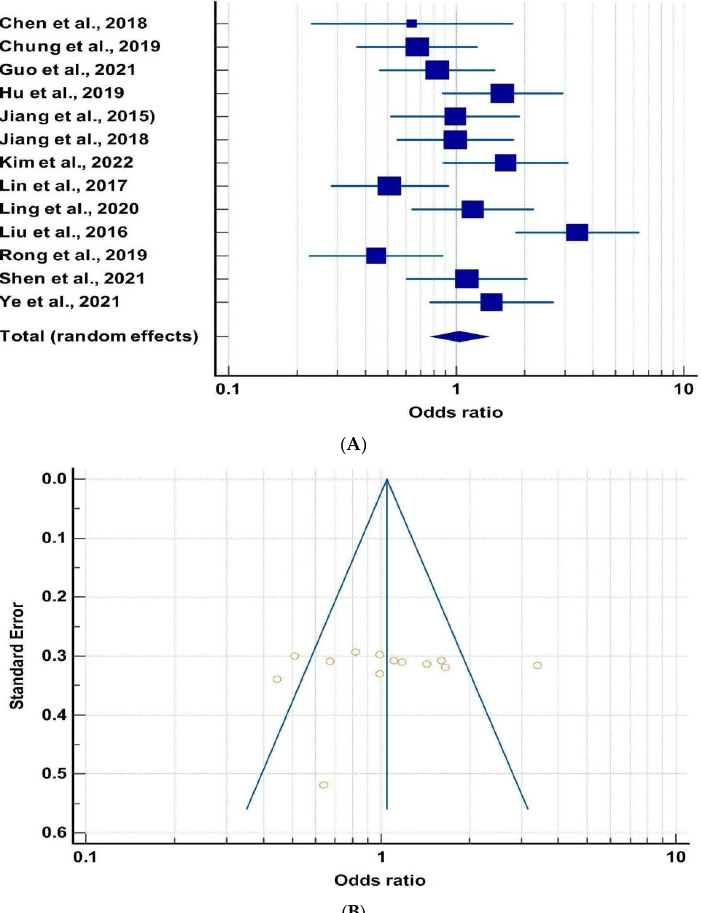
Figure 4. ( A ) Forest plot between mood disorders and microbiota [67–79]. The box and the horizontal lines represent study specific OR and 95% CI, respectively. The size of the box is an indicator of the weightage of that particular study. Here, odds ratio greater than 1 suggest that the relative abundance of Bacteroidetes is higher in people with mood disorders. ( B ) Funnel plot of mood disorders and microbiota for publication bias. microbiota for publication